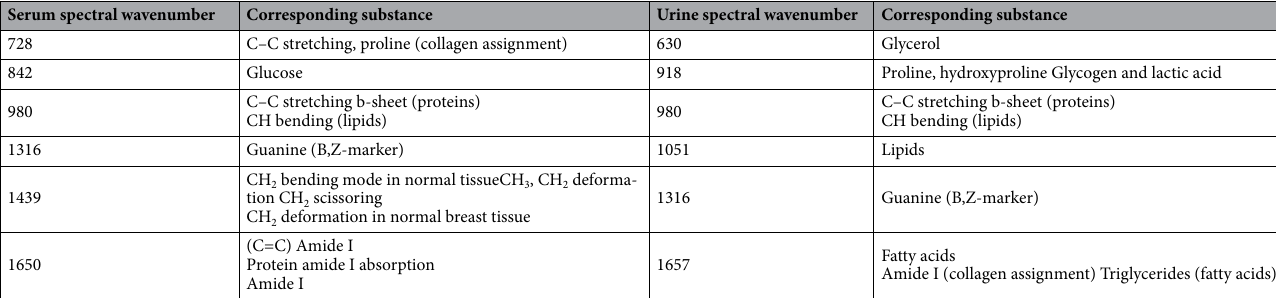
Table 2. Location and substance assignment of characteristic peaks in Raman